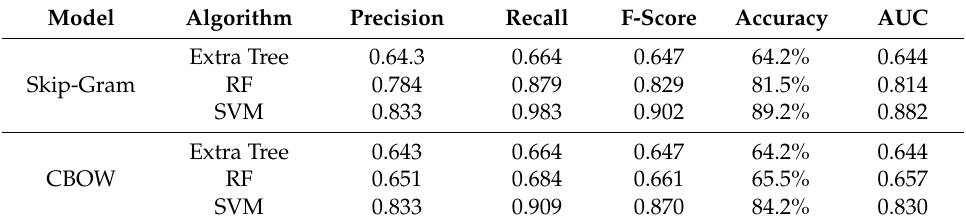
Table 18. Summary of classification algorithms with entity embedding model on test dataset.